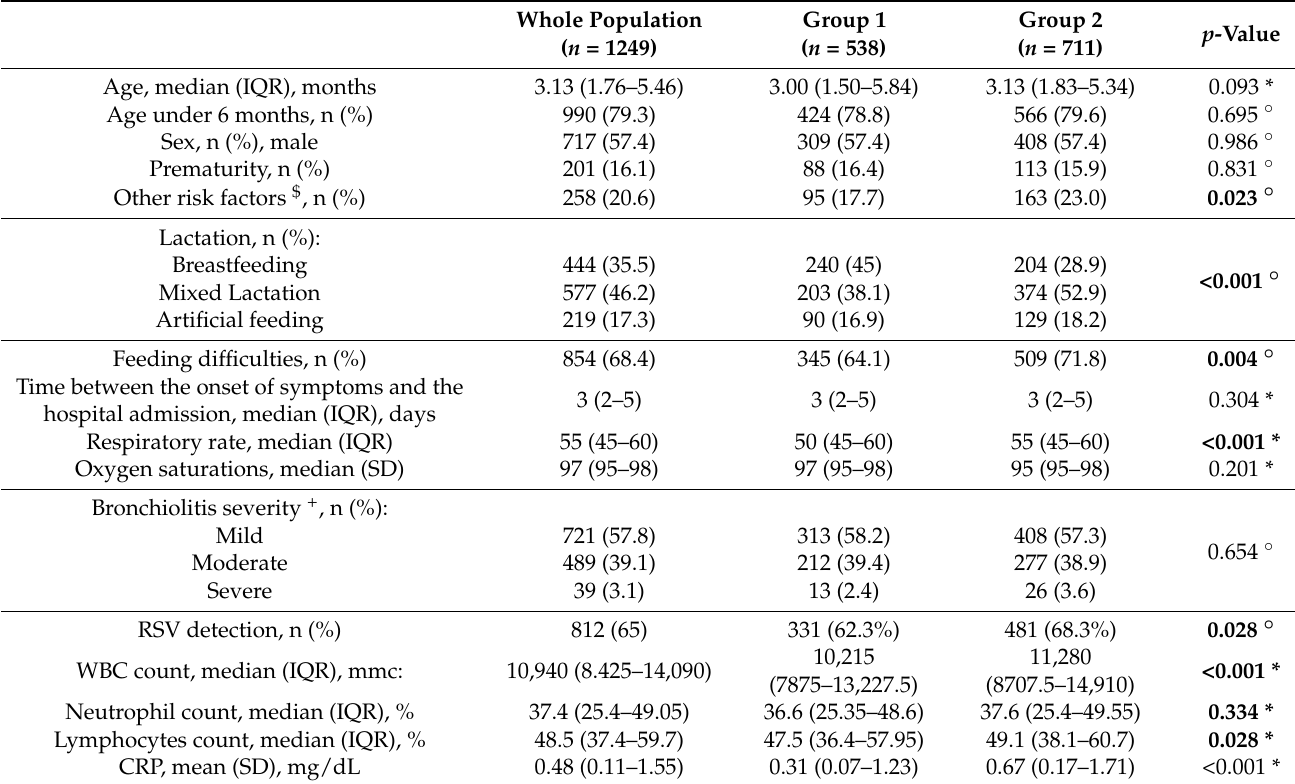
Table 2. Demographic, laboratory and clinical data of the study